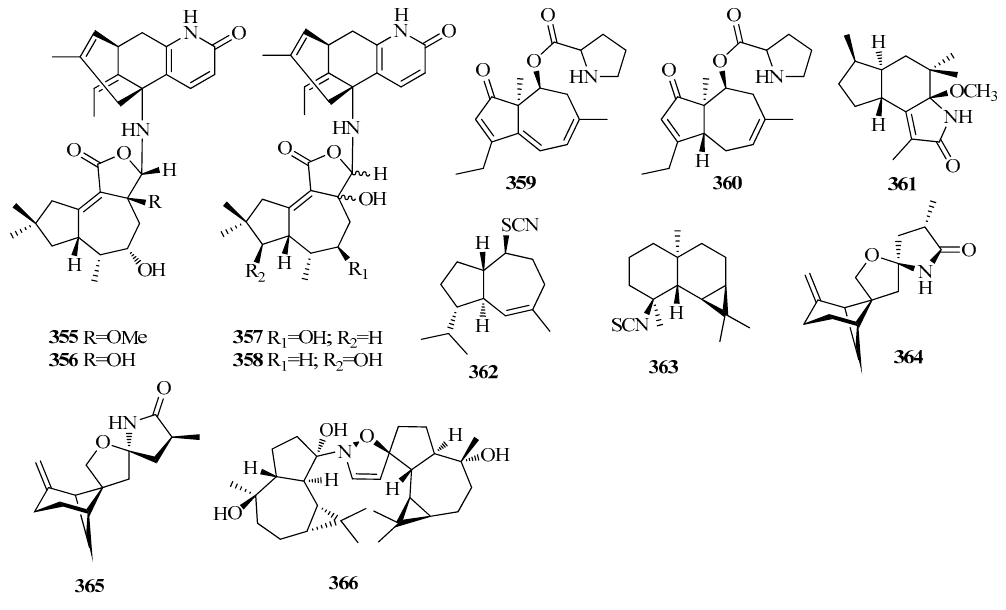
Figure 10. The structures of compounds 355 – 366.